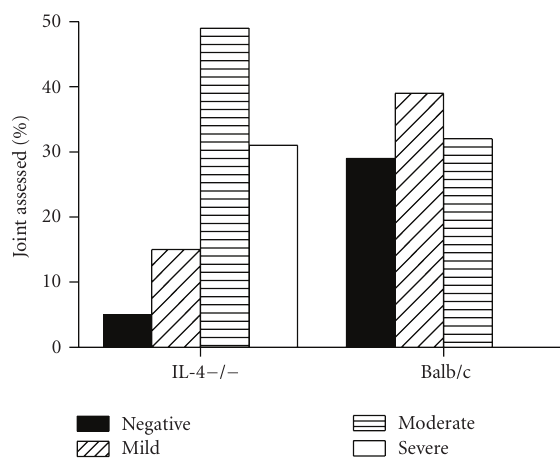
Figure 2: Histopathological findings. Histophatolgical severity of arthritis was assessed in IL-4 − / − mice or controls 10 days after infection. Arthritis was defined negative, mild moderate, or severe as detailed in Materials and Methods (see Section 2). Cumulative results of two independent experiments are represented. For each experimental group, 5 arthritic paws from IL-4 − / − mice or control mice were removed, and 3 joints for each paw were assessed for histopathological score.